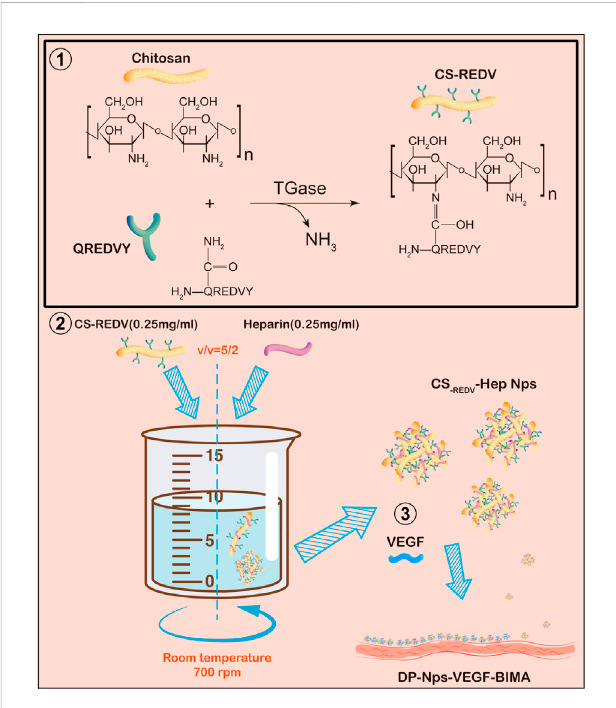
FIGURE 1 A schematic diagram of this study. Step 1: QREDVY peptides were grafted on chitosan side chain via transglutaminase catalysis to synthesize CS-REDV copolymers. Step 2: Mixing the .25 mg/mL CS- REDV solution and .25 mg/mL heparin solution slowly to form CS - REDV -Hep nanoparticles. Step 3: Immobilizing the CS -REDV -Hep Nps and VEGF onto the Decellularized and photo-oxidized bovine internal mammary artery. And then the grafts were test in vitro and in vivo